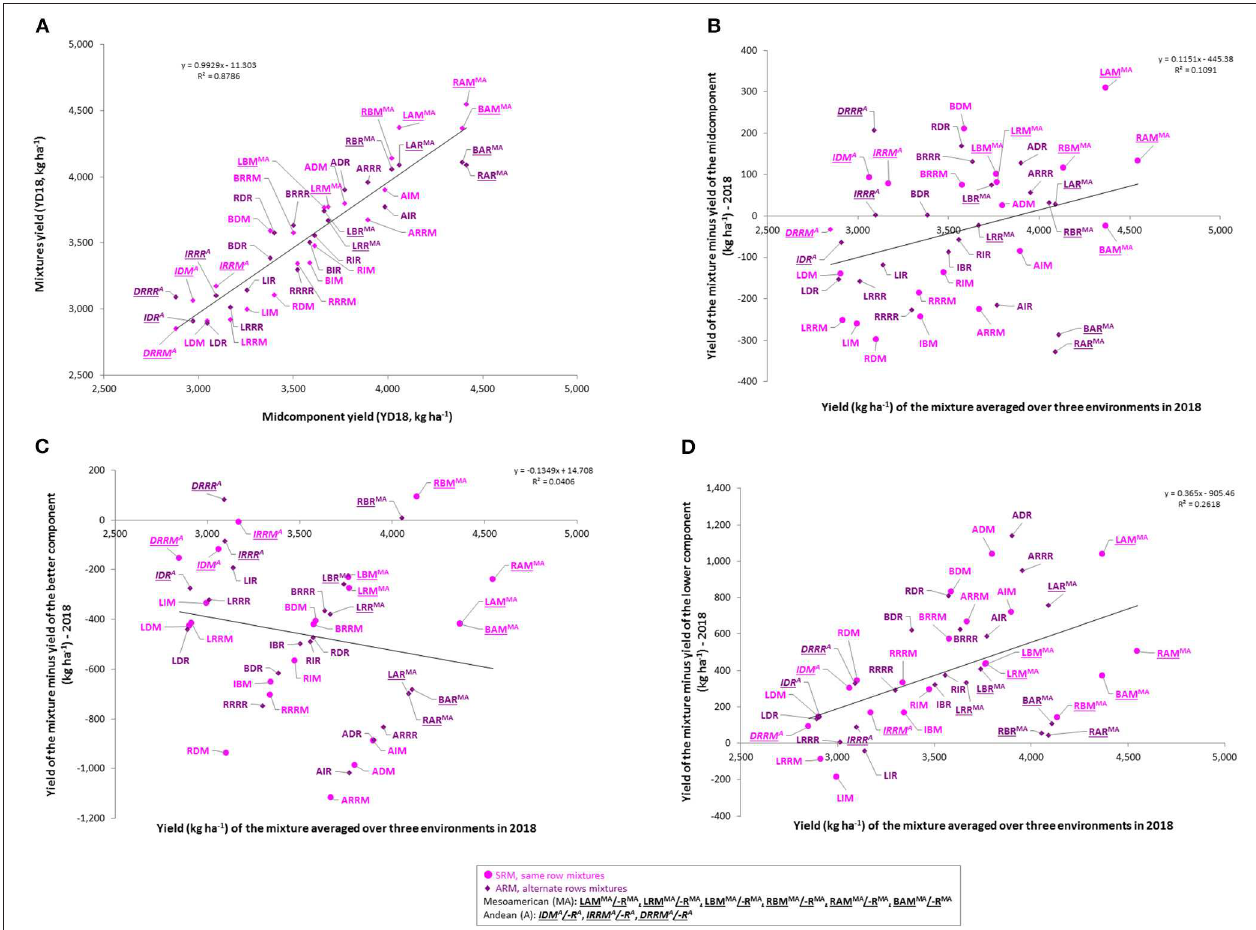
FIGURE 6 | Yield advantage of the common bean cultivar mixtures averaged over three Ontario environments/locations in 2018. (A) Yield of the mixtures compared to the yield of the midcomponent (mean of two cultivar components grown in pure stands); (B) Yield of the mixture vs. yield of the mixture minus yield of the midcomponent; (C) Yield of the mixture vs. yield of the mixture minus yield of the better component; (D) Yield of the mixture vs. yield of the mixture minus yield of the lower component. Mixture names consist of three letters: first letter indicates cultivar component 1 (L, Lighthouse; R, Rexeter; B, Bolt; A, OAC Vortex; I, OAC Inferno, D, Dynasty; RR, Red Rider), second letter indicated cultivar component 2 and the third letter indicates mixture type [M, same row mixture (SRM, pink); R, alternate rows mixture (ARM, purple)]. Mixtures of two Andean (A + A) or two Mesoamerican (MA + MA) cultivars are indicates by a superscript (MA or A) with their names [e.g. same row mixture between two Mesoamerican cultivars, Lighthouse and Rexeter (LRM MA ) or alternate rows mixture between two Andean cultivars, OAC Inferno and Dynasty (IDR A